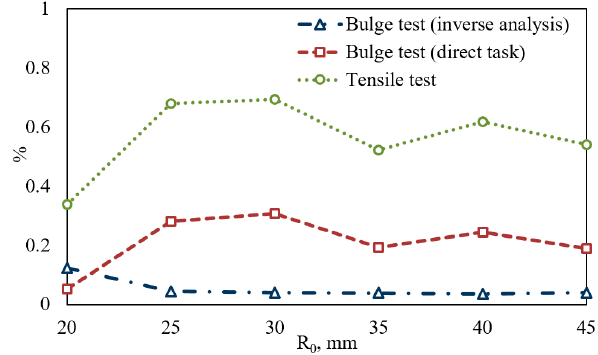
Figure 6. Deviation between experimental data and FE simulations.